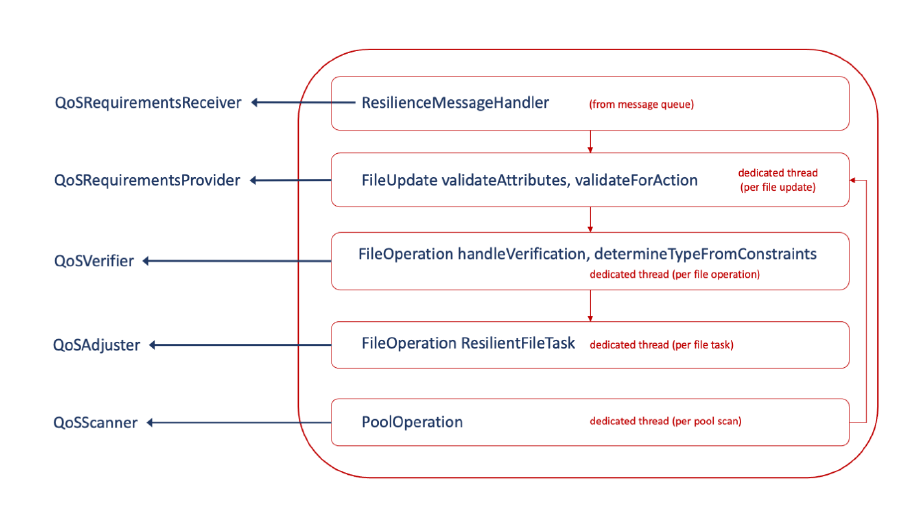
Figure 3. Resilience-to-QoS